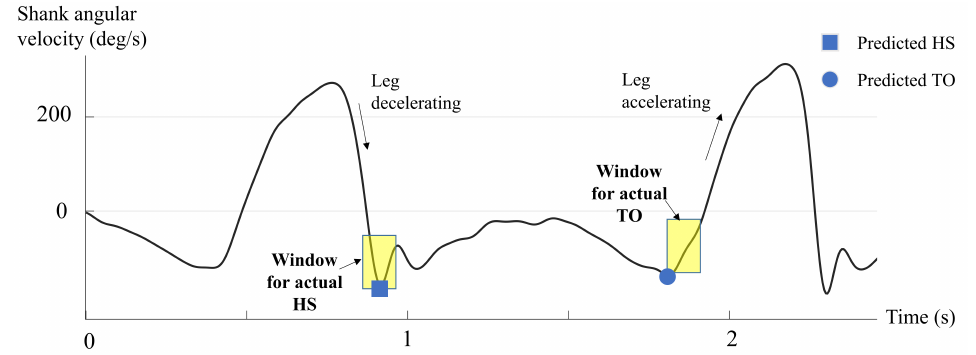
Figure 5. Typical shank velocity graph supplemented with the windows likely to contain the HS and TO events for a gait cycle based on the results of this